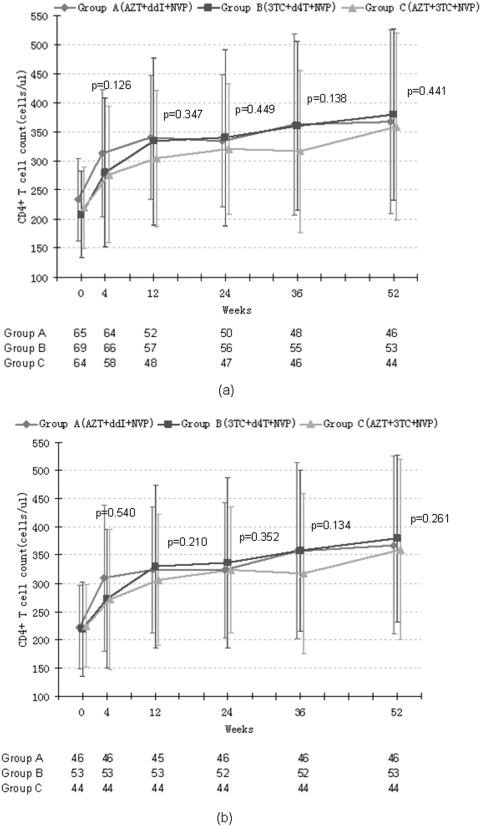
The increase of mean CD4+T cell count in three therapy group during HAART.According to an analysis based on the intention-to-treat analysis (a) and actual treat analysis (b). P value is calculated by comparing the CD4+ T cell count of three groups.